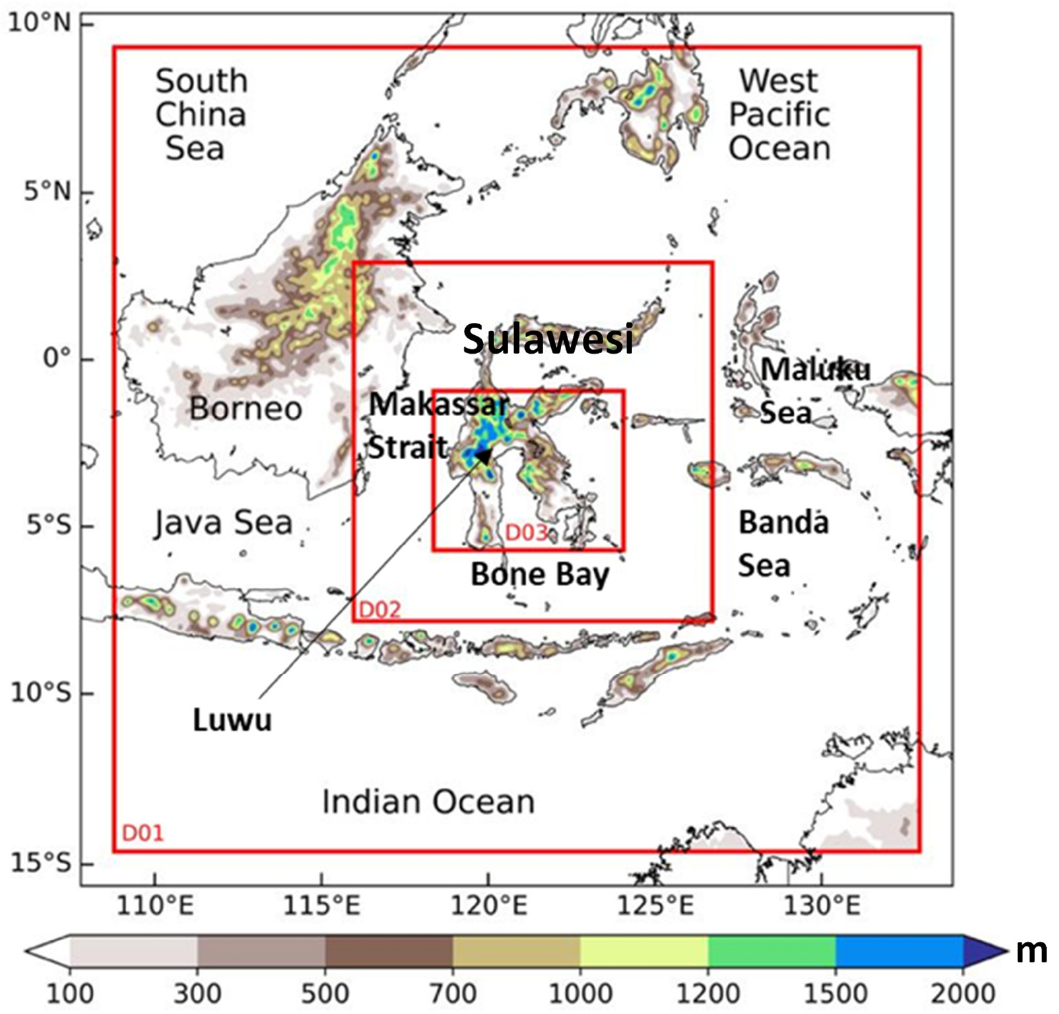
Figure 1. Simulation domain of the WRF model. Red boxes represent domains D01, D02, and D03, with resolutions of 9 km, 3 km, and 1 km, respectively. Color shading shows the terrain height.